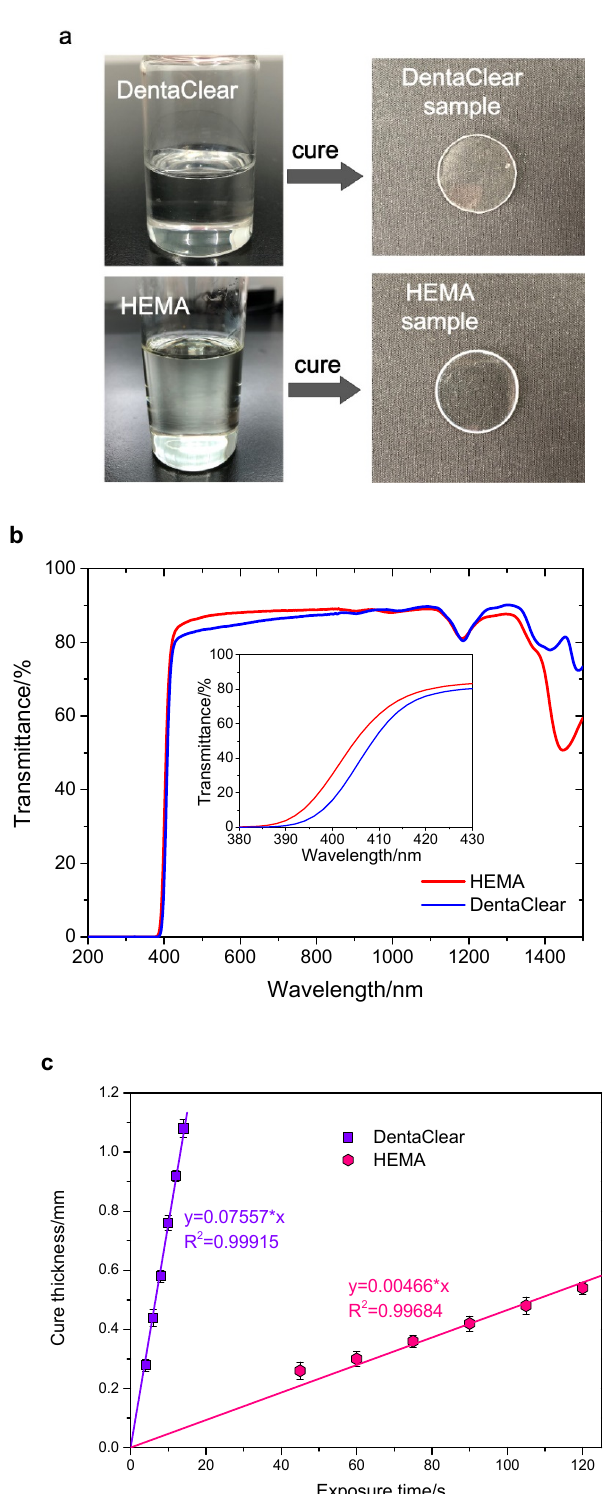
Figure 1. ( a ) Commercial UV-curable resin DentaClear, self-prepared resin HEMA, and test circle samples fabricated from DentaClear and HEMA. ( b ) Averages of spectral transmission curves measured on 5 samples. Both lenses made from DentaClear and HEMA possess high transparency in the visible range. ( c ) Curing thickness of the resins as a function of exposure time at a constant power of 32 mW/cm 2 . The curing thickness increases linearly with exposure time for both resins in the experimented